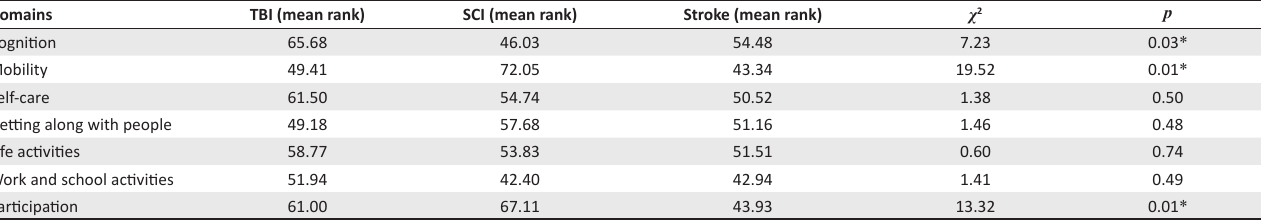
TABLE 4: Differences in severity of disability (as scored by World Health Organization disability assessment schedule 2.0) across neurological conditions ( n = 105). Domains